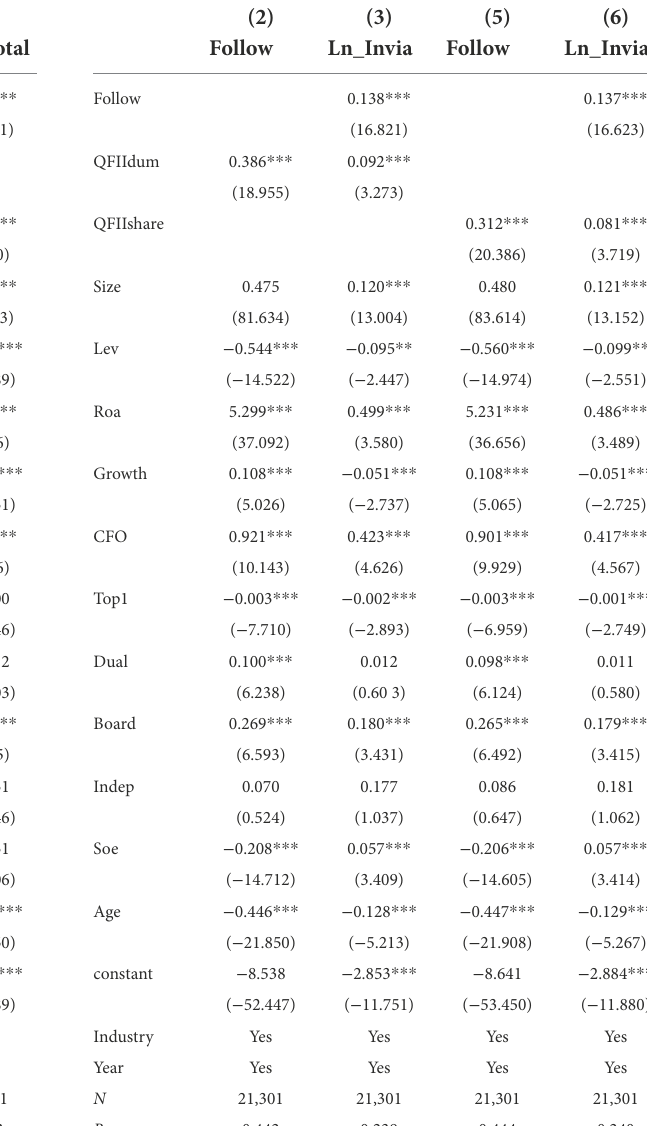
TABLE 6A The impact of QFII on the number of innovations: a mechanism test based on the number of analysts followed.